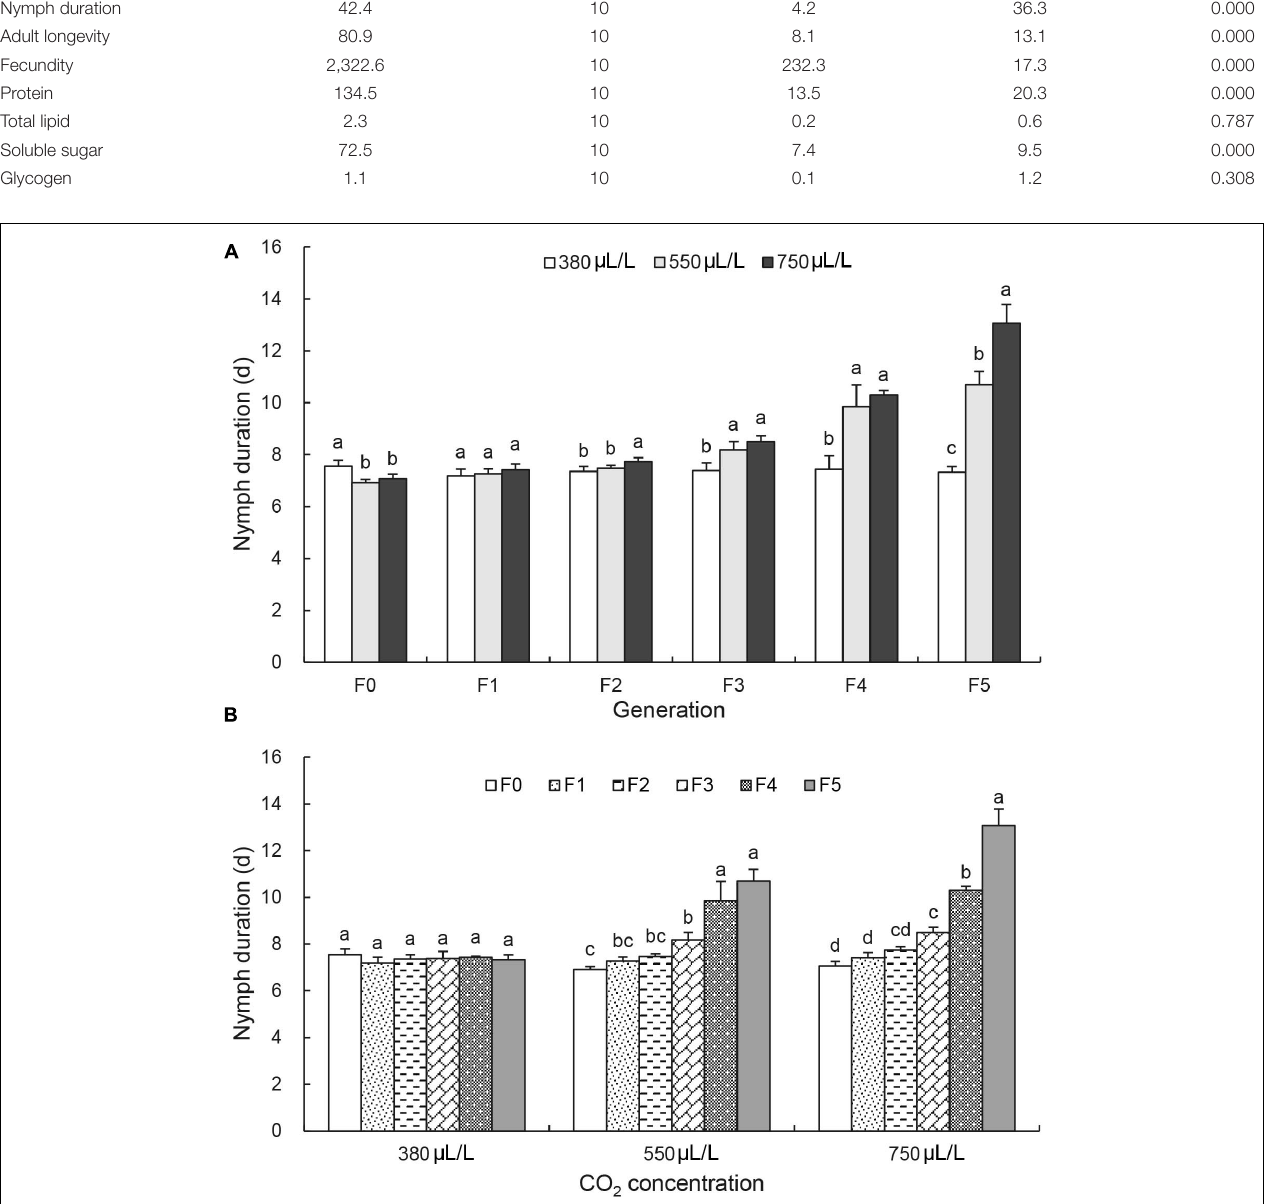
FIGURE 1 | Effects of CO 2 and generations on the nymph duration of A cyrthosiphon pisum . (A) Comparison of the effect of CO 2 levels (380, 550, and 750 µ L/L) at each of six generations (F 0 –F 5 ). (B) Comparison of the effect of generations under each of CO 2 levels (380 µ L/L, elevated 550 and 750 µ L/L). Different lowercase letters indicate significant differences between CO 2 levels at each generation (A) and between generations at each CO 2 level (B) as determined by one-way ANOVA Tukey’s HSD test at p <